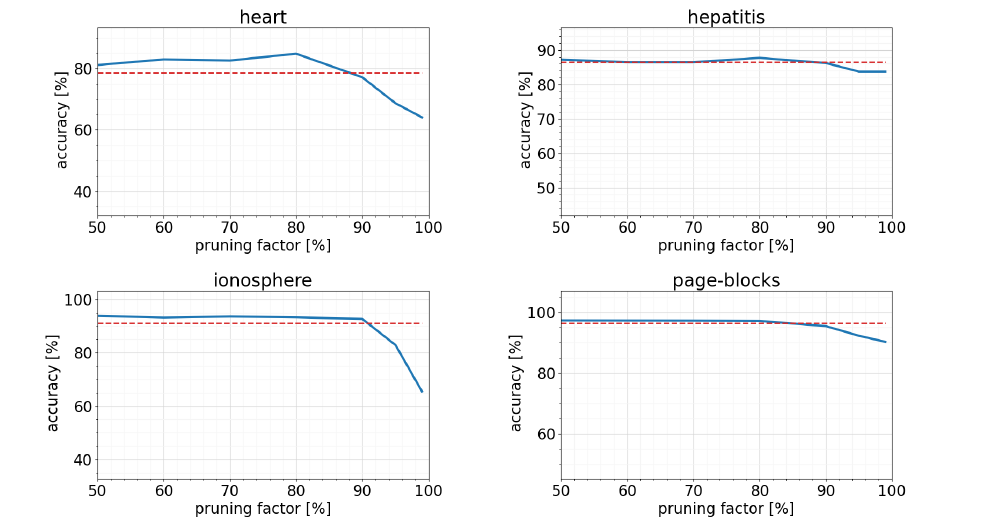
Figure 12. Results of pruning MLP ANN structure on heart, hepatitis, ionosphere and page-blocks